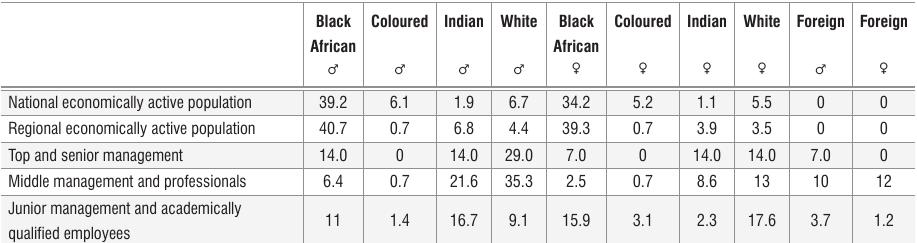
Demographic percentages for the national and regional (KwaZulu-Natal) economically active population and categories of University of KwaZulu-Natal